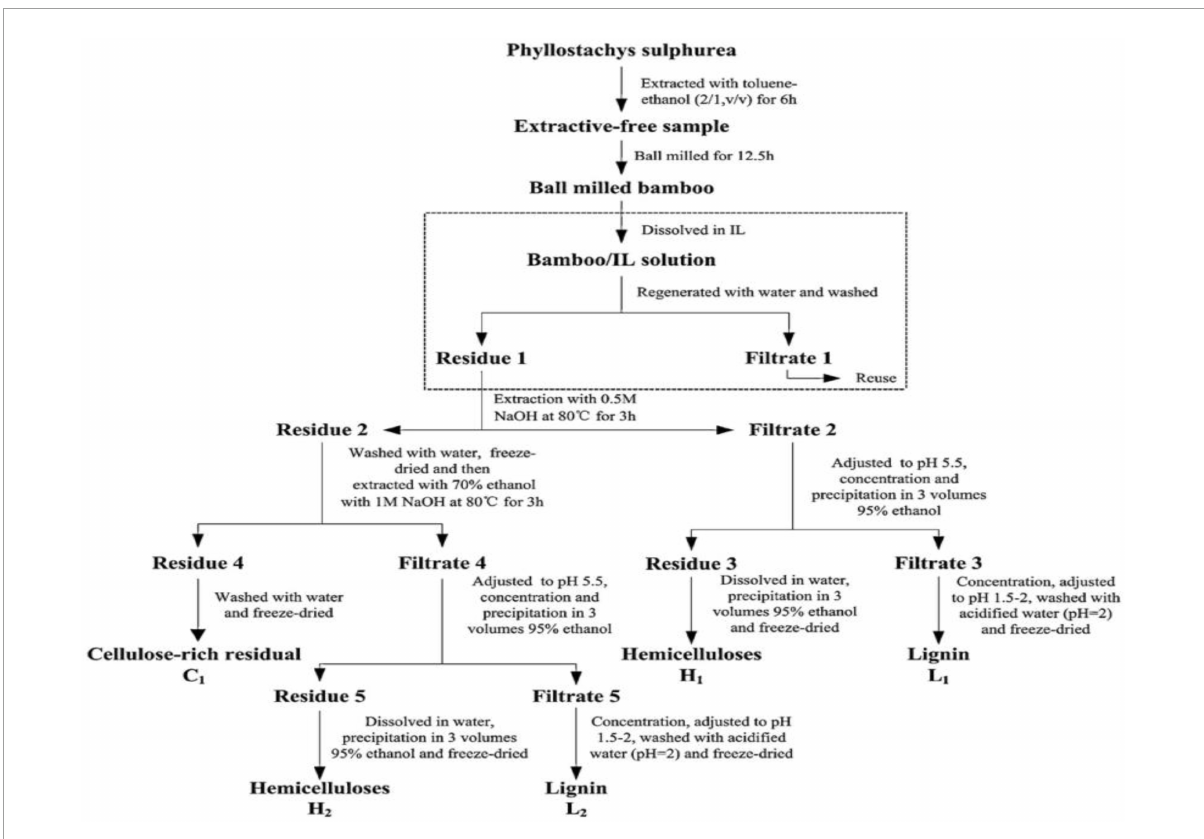
FIGURE2 The process of extracting cellulose, hemicellulose, and lignin from bamboo with the assistance of ILs. Reprinted from Yang et al. (2013) with permission from